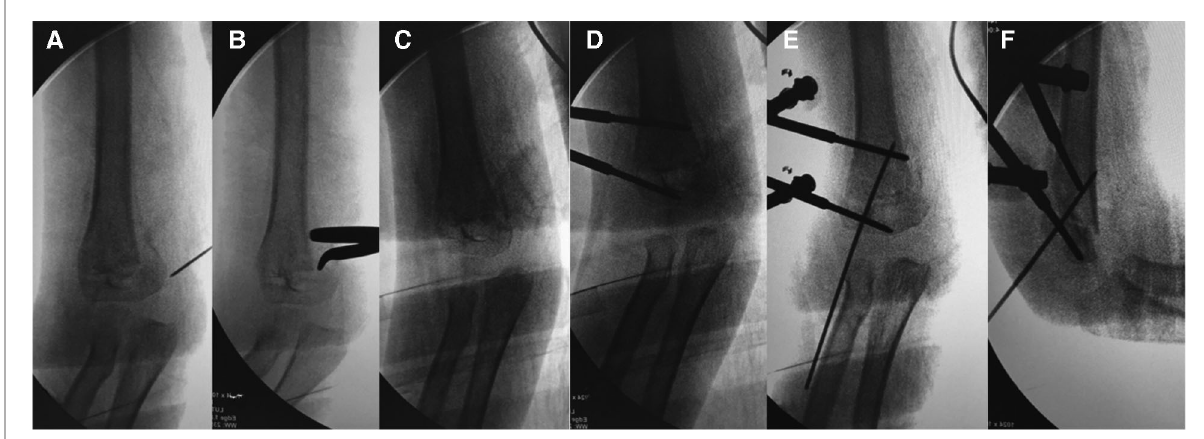
FIGURE 1 C-arm image during the surgical procedure of a 5-year-old boy with delayed supracondylar fracture of right humerus: ( A ) the fracture line with callus was located with a needle; ( B ) lateral, anterior, and posterior calluses were removed from the humerus horizontally along the fracture line with the hemostat; ( C ) manual reduction of fractures was performed to correct the abnormal carrying angle; ( D ) external fi xation with two schanz pins was used; ( E ) placement of K-wire was served as a de-rotational wire to stabilize the fracture; ( F ) lateral view of the elbow after fi